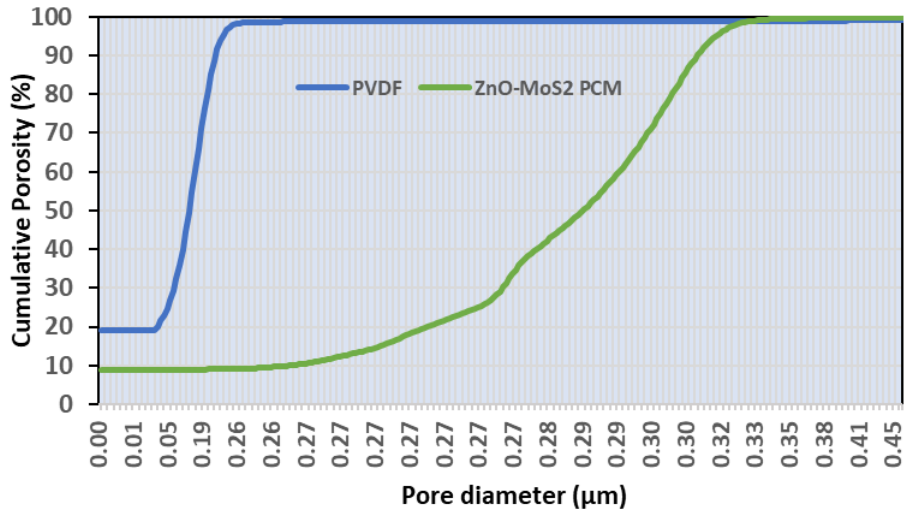
Figure 9. Pore diameter vs. cumulative porosity of the virgin and the modified PVDF membranes.